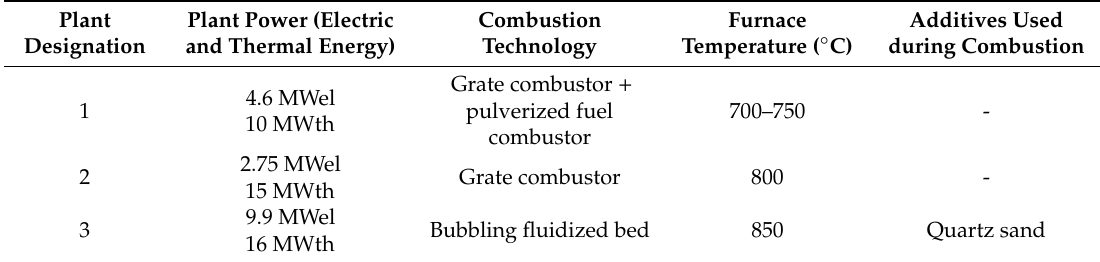
Table 1. Plant characteristics.